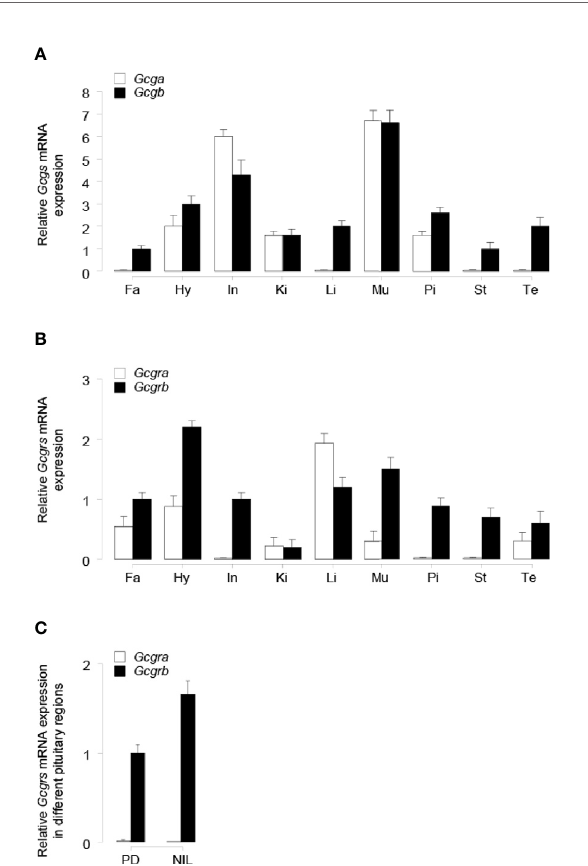
FIGURE 4 | qPCR assay of tilapia (A) Gcgs , and (B) Gcgrs mRNA levels in various tissues. The tissues tested in the present study are as follows: Fa, fat; Hy, hypothalamus; In, intestine; Ki, kidney; Li, liver; Mu, muscle; Pi, pituitary; St, stomach; Te, testis. (C) Expression pro fi les of tilapia Gcgra and Gcgrb in different pituitary regions, including the pars distalis (PD) and the neurointermediate lobe (NIL) region. The error bar for Gcgra transcripts in NIL cells was too small to be shown on the plotted scale. The transcripts levels of target genes were normalized by that of b -actin and expressed relative to the fat Gcgb , Gcgrb , and PD Gcgrb levels. The data point of each tissue represents the mean ± SEM of six